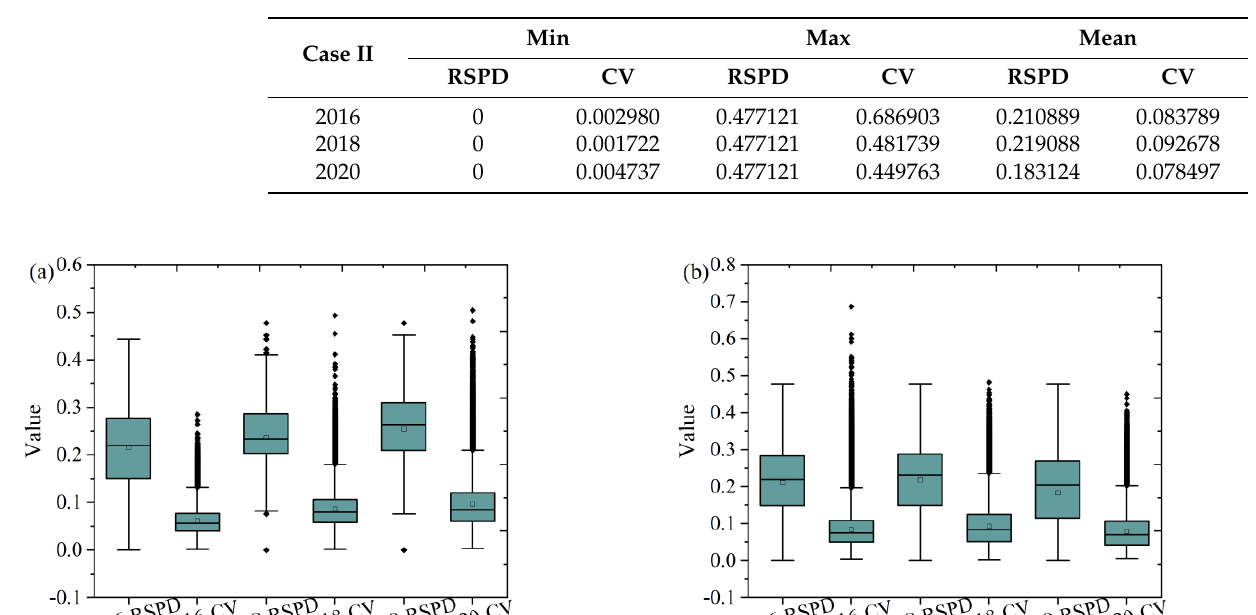
Table 3. Statistical analysis of RSPD and CV in Case II.